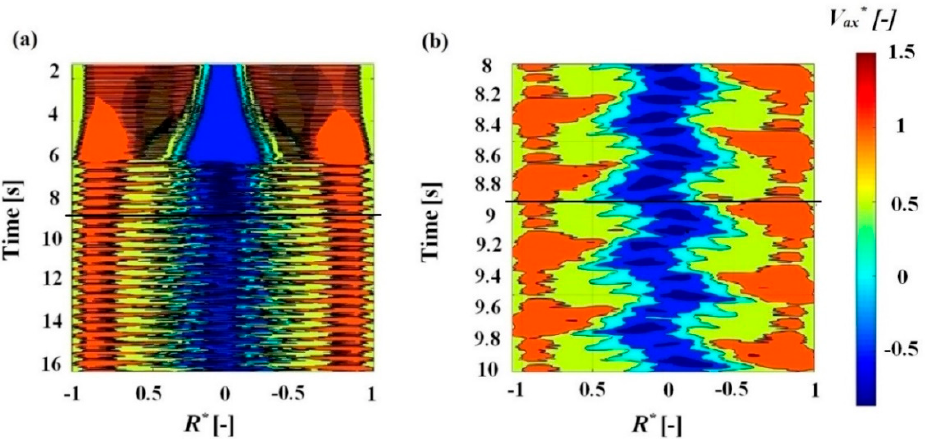
Figure 18. Normalized axial velocity at Section I. ( a ) and detail around the end of the guide vane closure ( b ). The black horizontal line represents the ending of the transient operation.